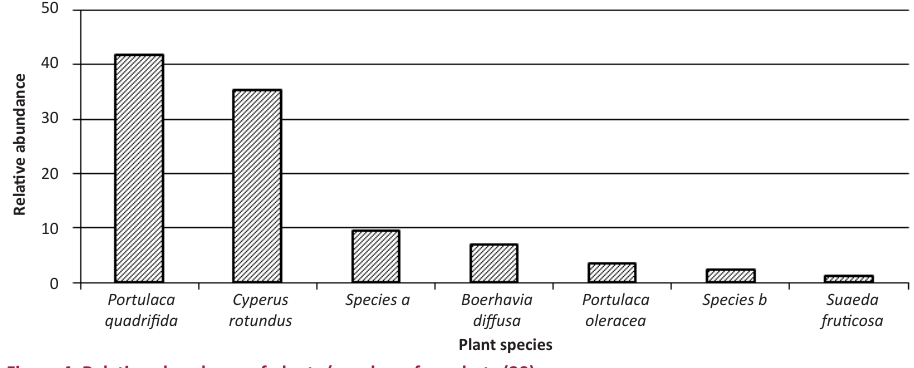
Figure 4. Relative abundance of plants (number of quadrats (20)